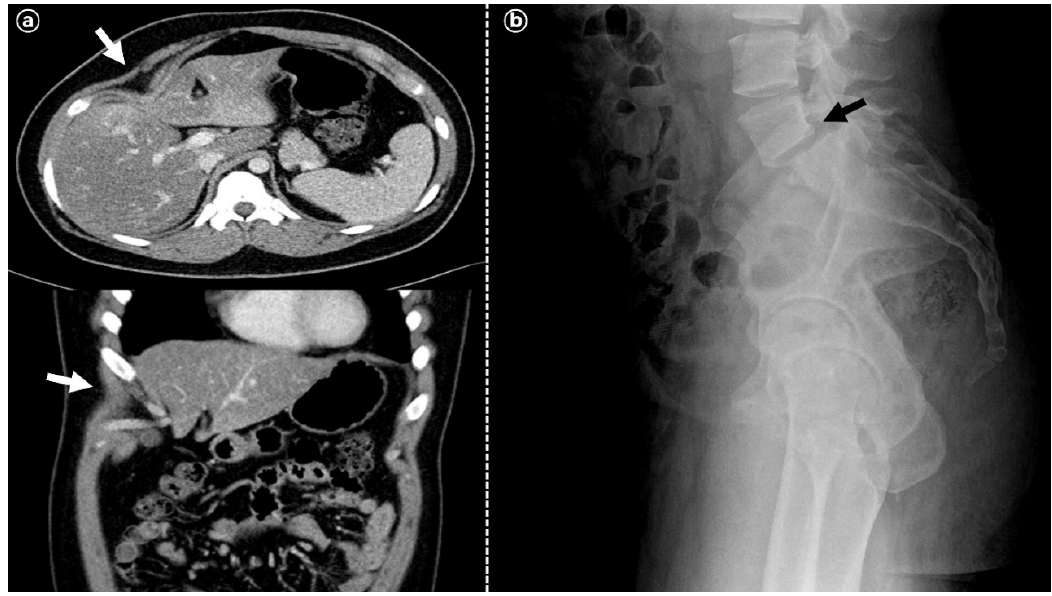
Figure 1. Skeletal deformities of the patient. ( a ) Axial and coronal CT scan sections showing abnormally curved right 8th rib and costal that directly compress the liver (white arrow); ( b ) sagittal lumbosacral X ray showing spondylolisthesis of L5-S1 (black arrow).